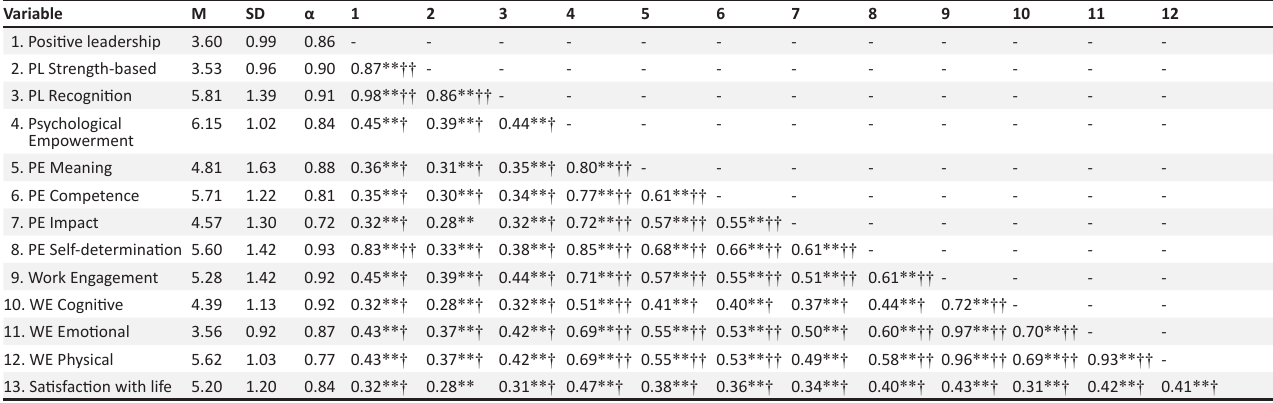
TABLE 2: Descriptive statistics, alpha coefficients, and correlations. Variable